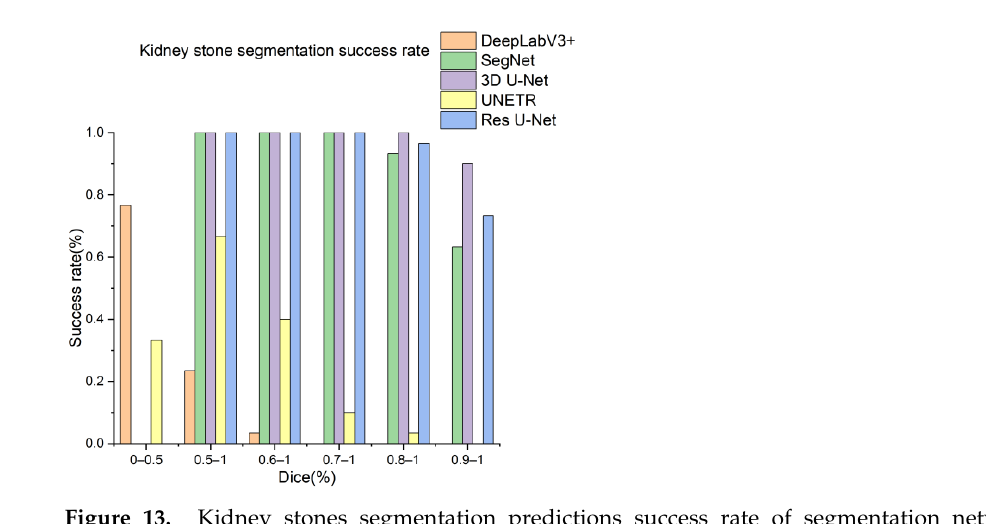
posed training scheme.